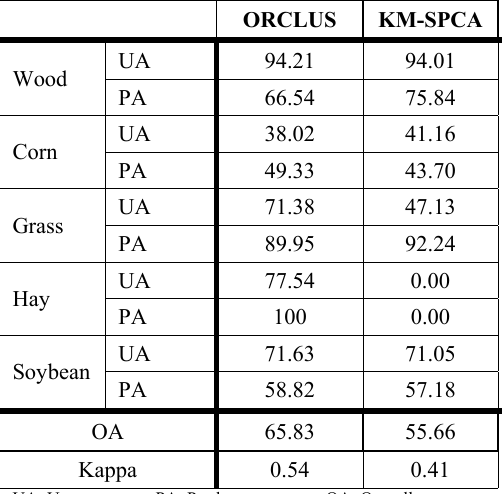
Figure 2. (a) Ground reference image of Indian Pines dataset with color codes for different classes, and Classification maps obtained by (b) ORCLUS, (c) KM-SPCA. Table 1. Various accuracy indicators obtained by the two clustering methods for Indian Pines dataset. Figure 3. (a) Ground reference image of Salinas-A dataset